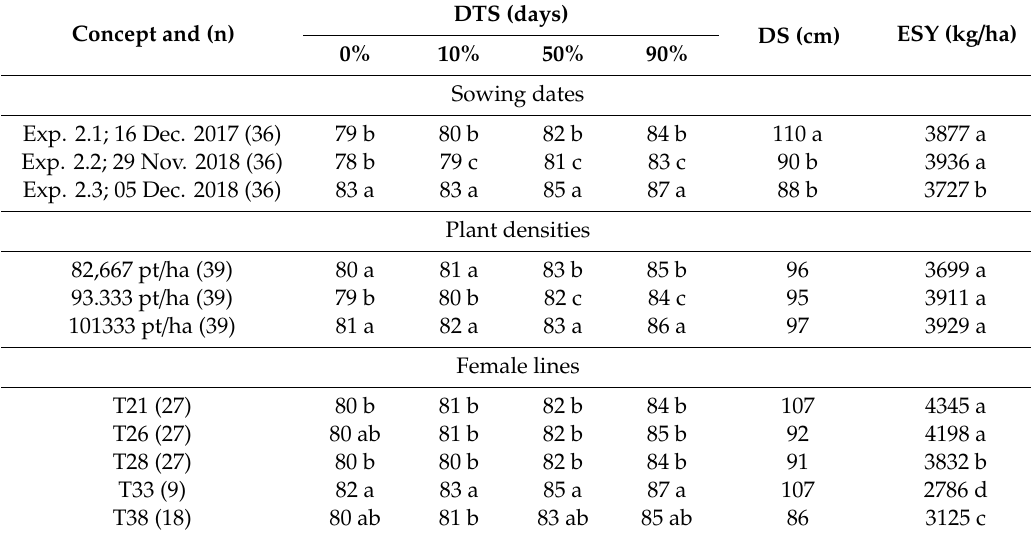
Table 7. Means by sowing dates, plant densities of female lines in Experiment